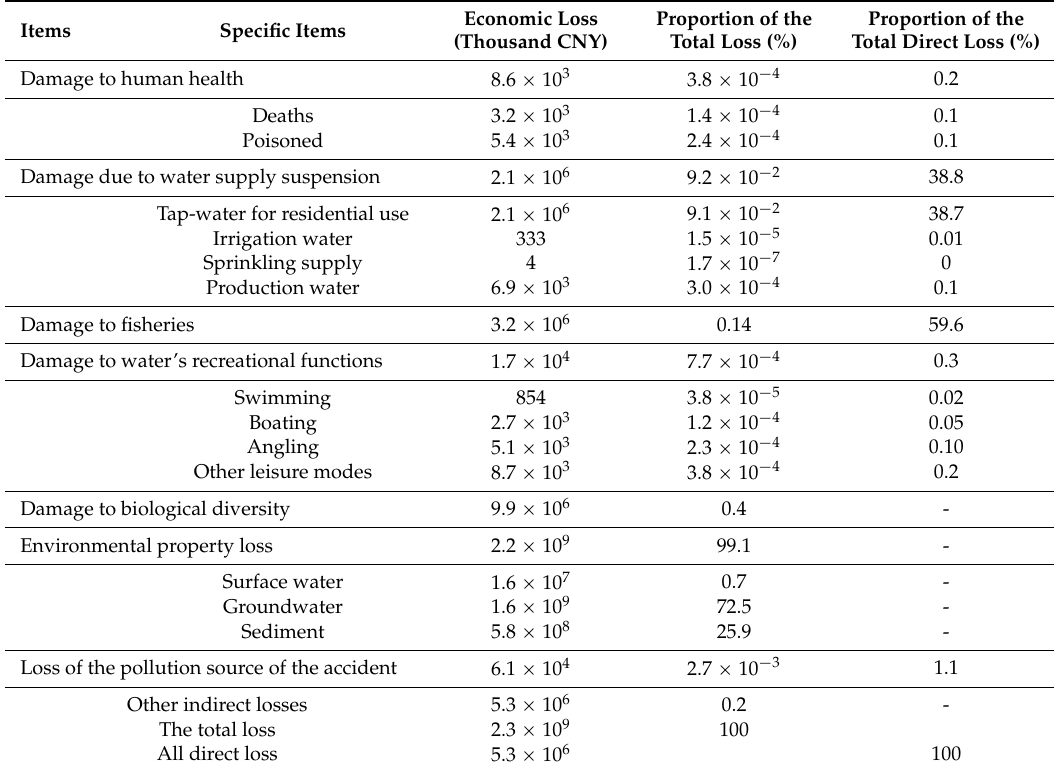
Table 6. The details of the economic losses of the Songhuajiang pollution accident.